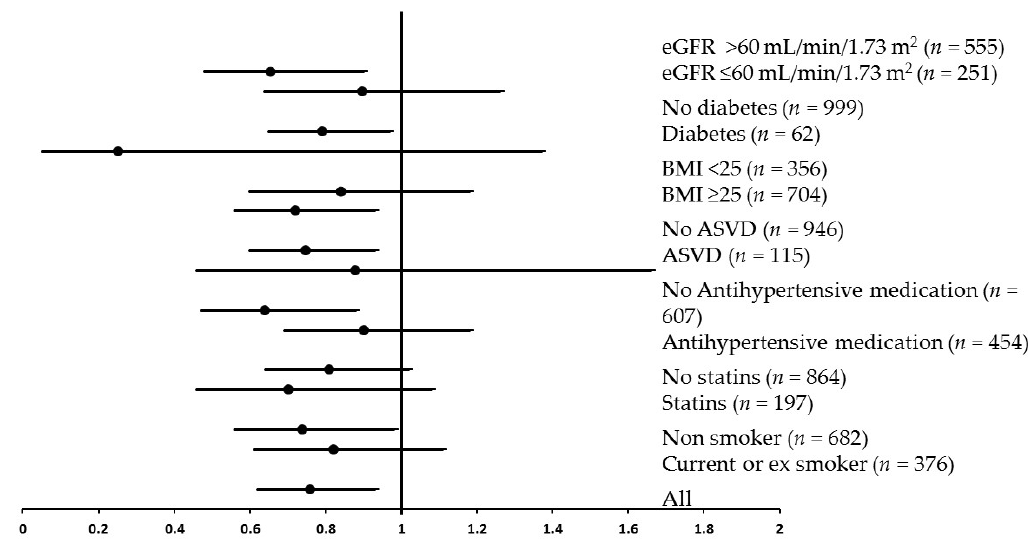
Figure 2. The odds ratio and 95% confidence interval of severe abdominal aortic calcification for each SD increase in apple intake (50 g/day) stratified by estimated glomerular filtration rate (eGFR) diabetes, BMI, prevalent atherosclerotic vascular disease (ASVD), use of antihypertensive medication, use of statins and smoking status. Multivariable adjusted for age, BMI, energy intake, energy expended in physical activity, alcohol consumption, prevalent atherosclerotic vascular disease, previous type 2 diabetes, use of antihypertensive medication, use of cholesterol-lowering medication (statins), and smoking status. There was no significant interaction of apple intake with any of the strata for these parameters in predicting severe AAC ( p > 0.05).